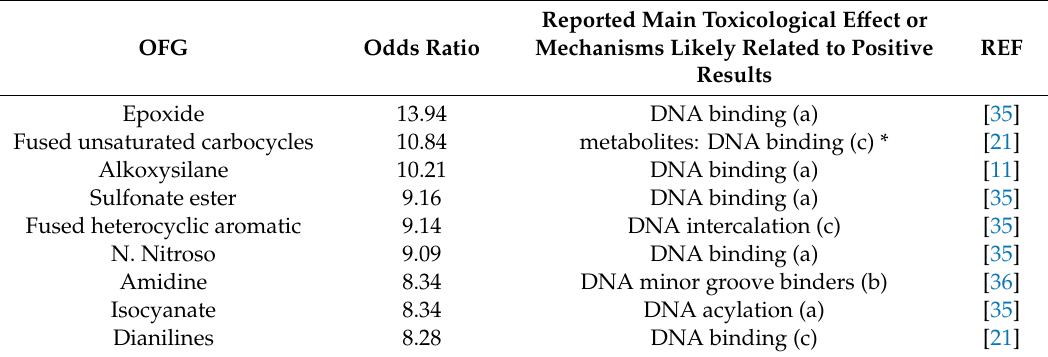
Table 2. OFGs related to positive